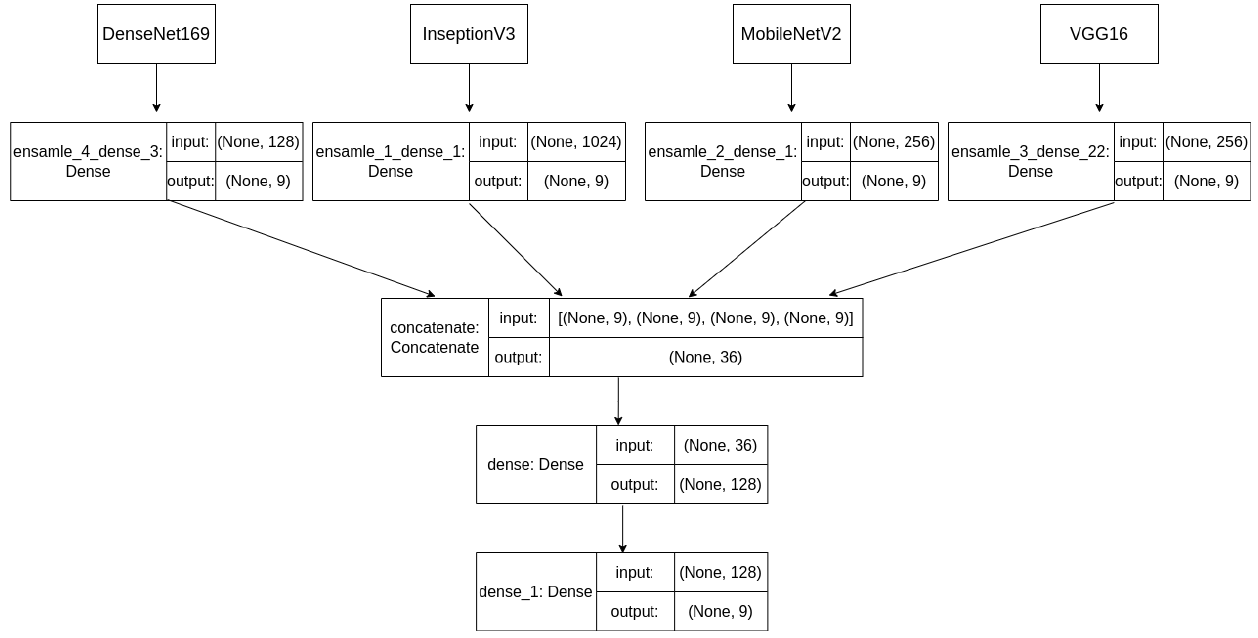
Figure 6. Neural Network Stacking Ensemble. Table 8. Summary of the custom layers added to the architecture based on classifier